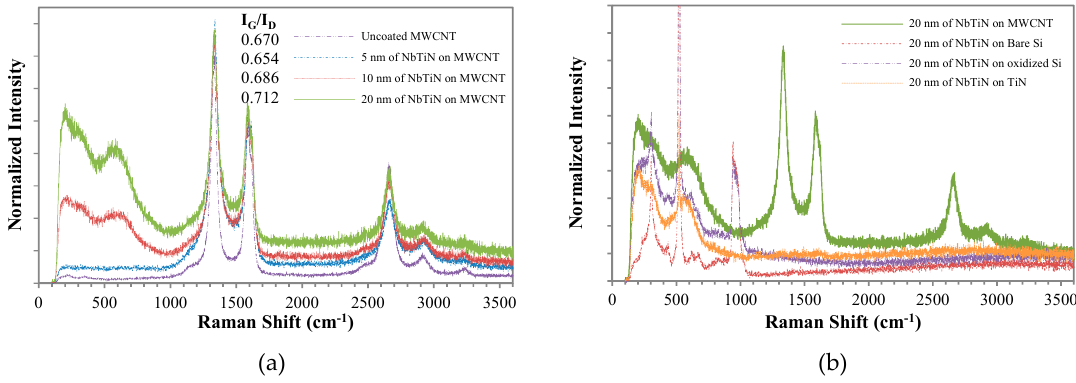
Figure 4. Normalized Raman spectra of ( a ) coated MWCNT with different thicknesses of NbTiN and ( b ) 20 nm NbTiN on various points of the substrate.